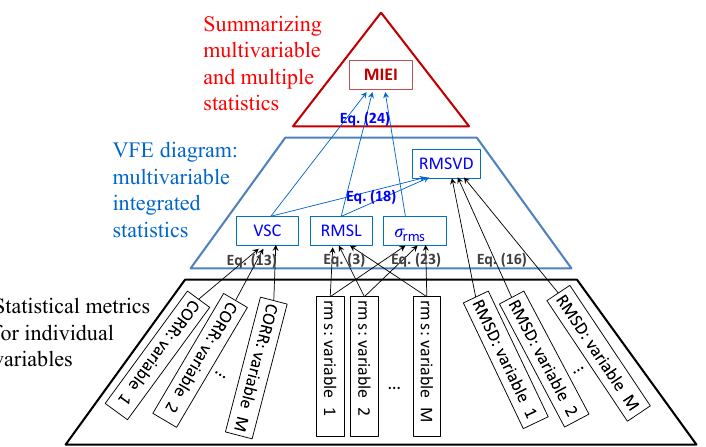
Figure 4. Pyramid chart showing the relationship between three levels of metrics. The first level of metrics, i.e., correlation coefficient (CORR), rms value, and RMSD, measures the model performance in terms of individual variables. The second level of metrics, i.e., VSC, RMSL, standard deviation of rms values ( σ rms ), and RMSVD, is derived from the first level of metrics and summarizes the overall perfor- mance of a climate model in simulating multiple fields. The MIEI further summarizes the VSC, RMSL, and σ 2 rms into a single index to rank various climate models in terms of simulating multiple